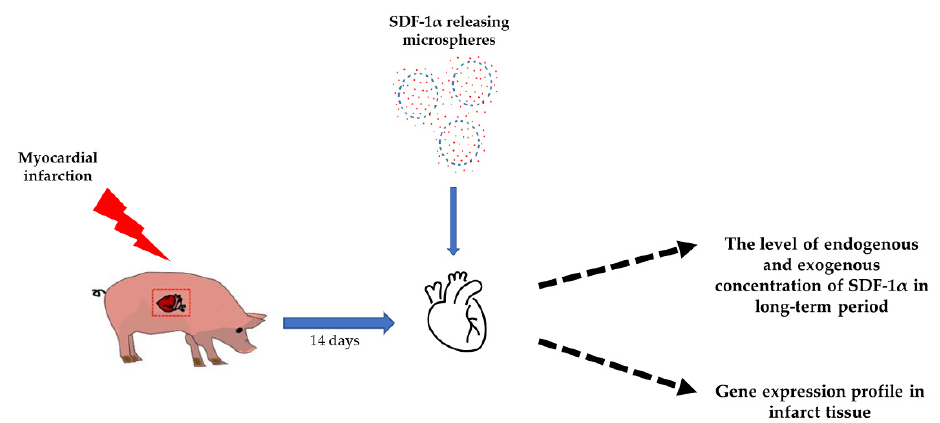
Figure 1. Study design. Fourteen days after myocardial infarction, SDF-1 α released from micro- spheres were transferred to the pericardium sac. The effect of SDF-1 α was investigated using ELISA test, measuring the level of endogenous and exogenous concentrations of SDF-1 α over a long-term period, and RT-qPCR, examining the gene expression profile in the infarct